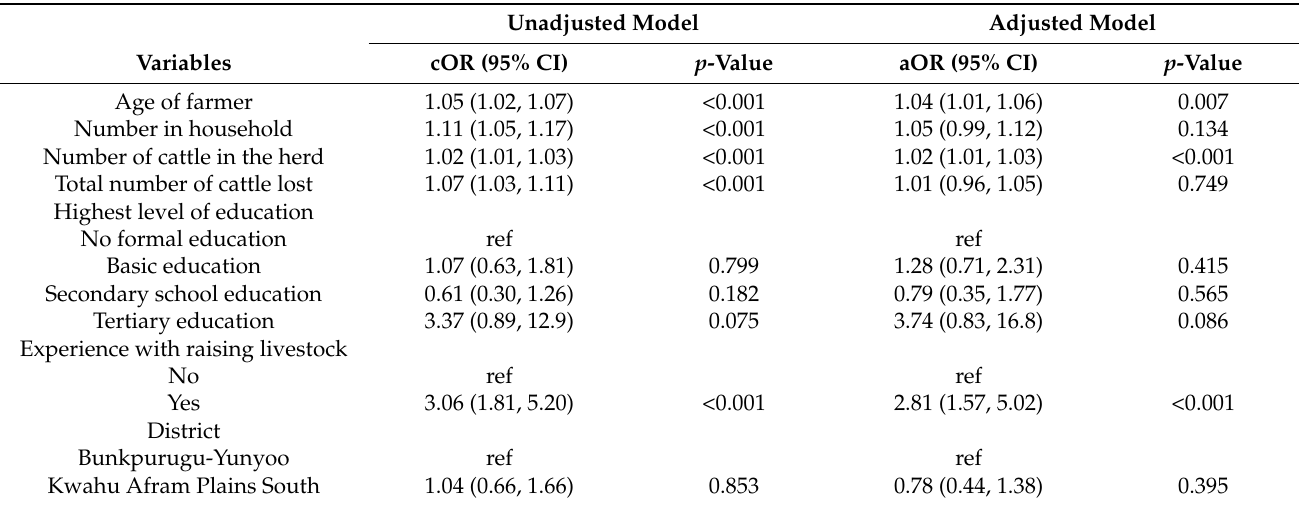
Table 4. Factors predicting high resilience levels of cattle farmers in the Bunkpurugu-Yunyoo and Kwahu Afram Plains South districts,